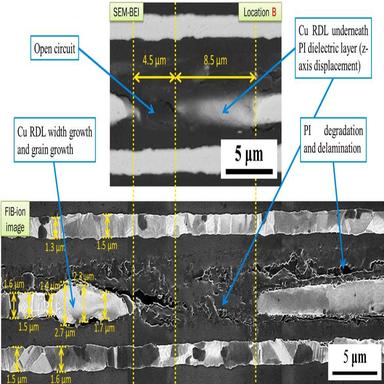
Top-view backscattered (SEM-BEI) and FIB ion-imaging microstructures of the failed Cu interconnect, corresponding to the confined location B in, after the electromigration experiment. (1.5-column; Color online). (For interpretation of the references to color in this figure legend, the reader is referred to the Web version of this article.)